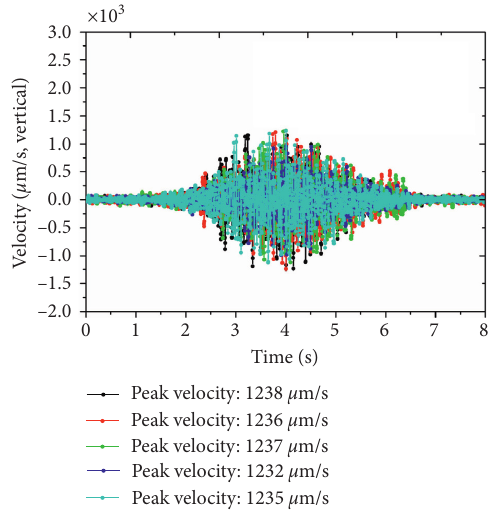
Figure 10: Velocity time histories of the vibration